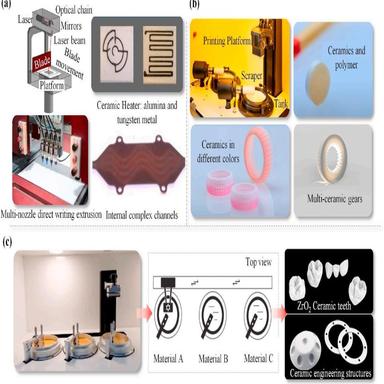
Domestic and overseas multi-material ceramic additive forming equipment: (a) multi-material ceramic SLA printer and multi-material parts printed by 3DCERAM, (b) DLP multi-material ceramic 3D printer and multi-material ceramic prototypes printed by Lithoz, (c) DLP multi-material ceramic 3D printer and ceramic parts printed by Xunshi Technology Inc.